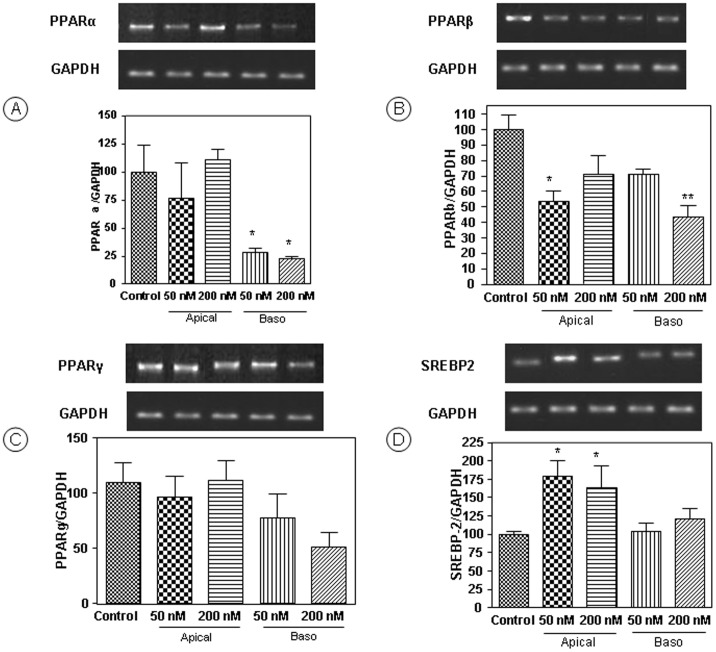
Effects of the administration of PYY (1–36) to the apical or basolateral medium on PPAR and SREBP-2 gene expression in Caco-2/15 cells.PCR analysis was performed on Caco-2/15 cell line at 14 days post-confluence to analyze mRNA of PPARα (A), PPARβ (B), PPARγ (C), SREBP-2 (D). Values represent means ± SD for n = 3 separate experiments in each group and are reported as percent difference relative to control. * P<0.05 vs. controls, **P<0.01 vs. controls.